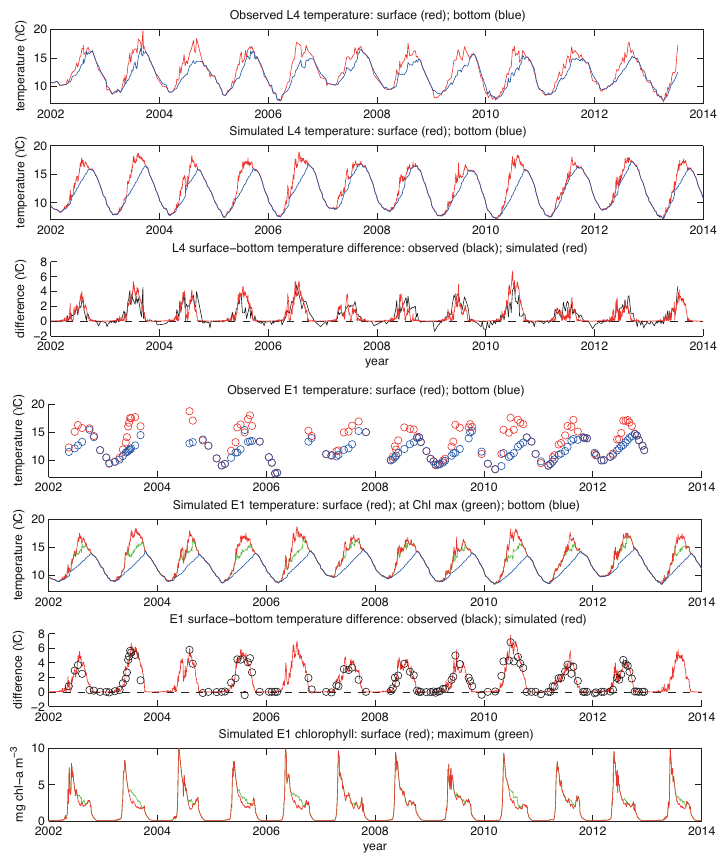
Figure 6. Time series of surface–bottom temperature differences observed and (daily) simulated at L4 and E1 (http://www.